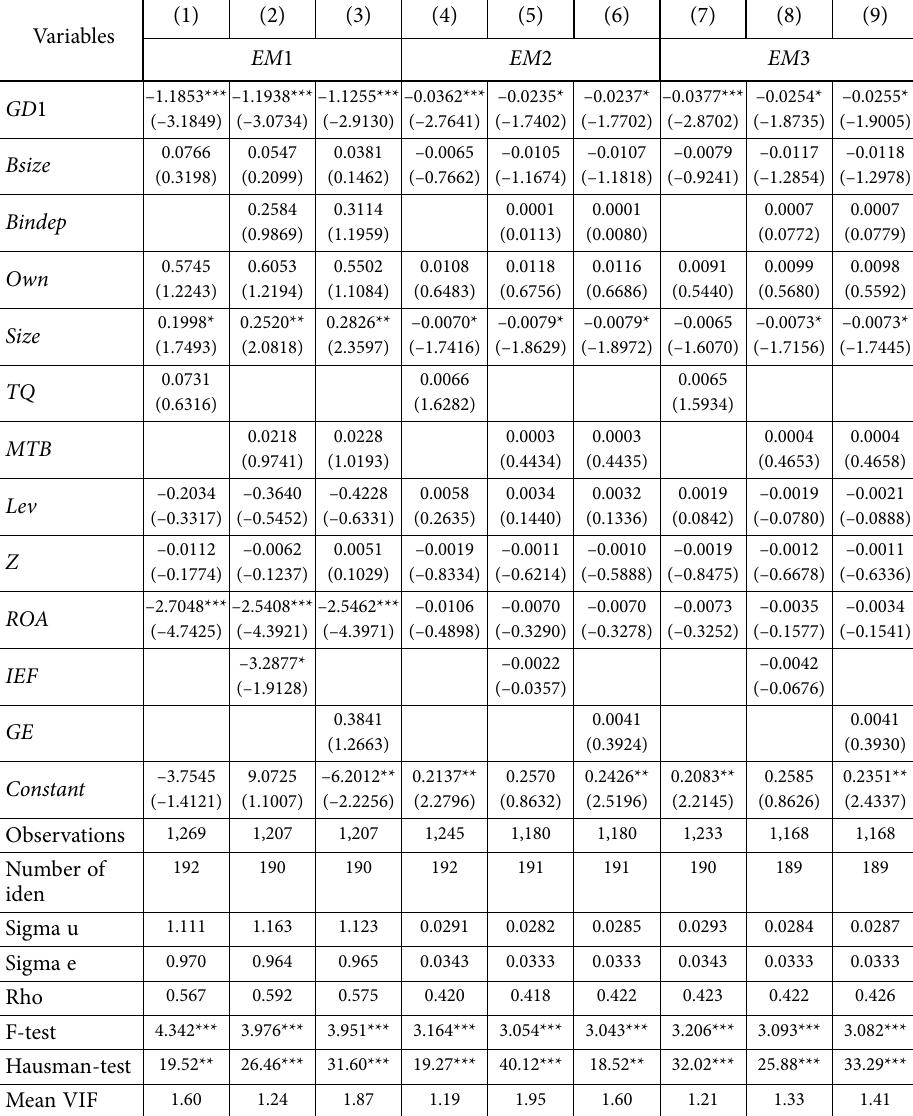
Table 5. Women on board and earnings management (OLS-FE